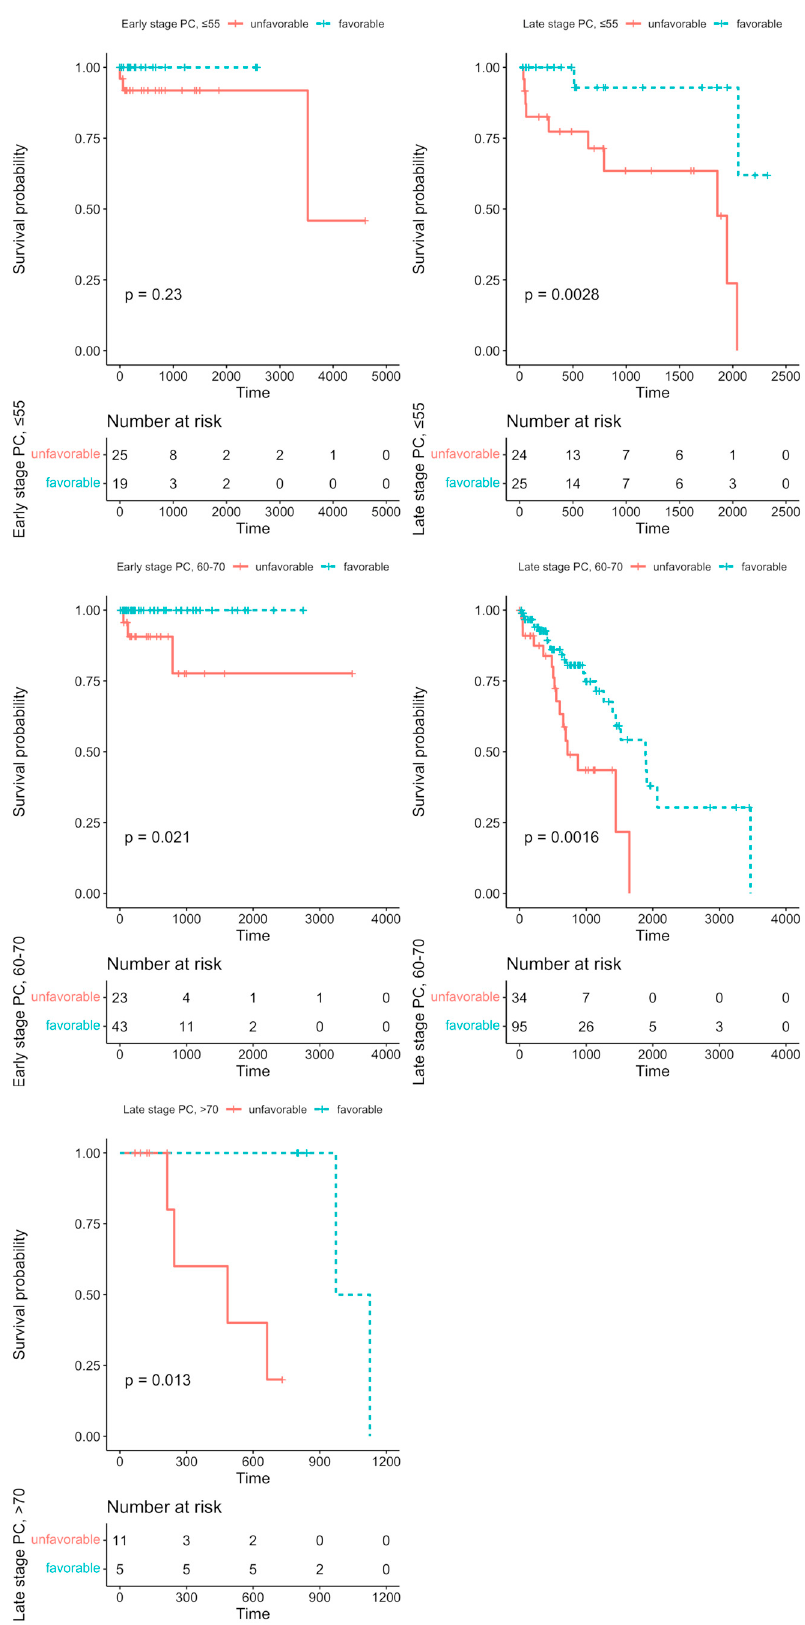
Figure 2. The specified Notch patterns of expression altered the DFS among subgroups of PC patients through the modulation of reshaping the cellular architecture. The unfavorable prognosis of signatures consisting of RBPJ , ADAM17 , RBPJL , ATXN1 in early-stage PC below 55 years old,